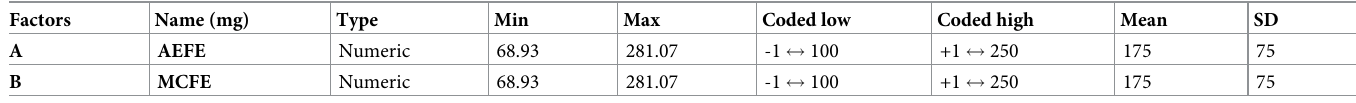
Table 1. Design summary for independent